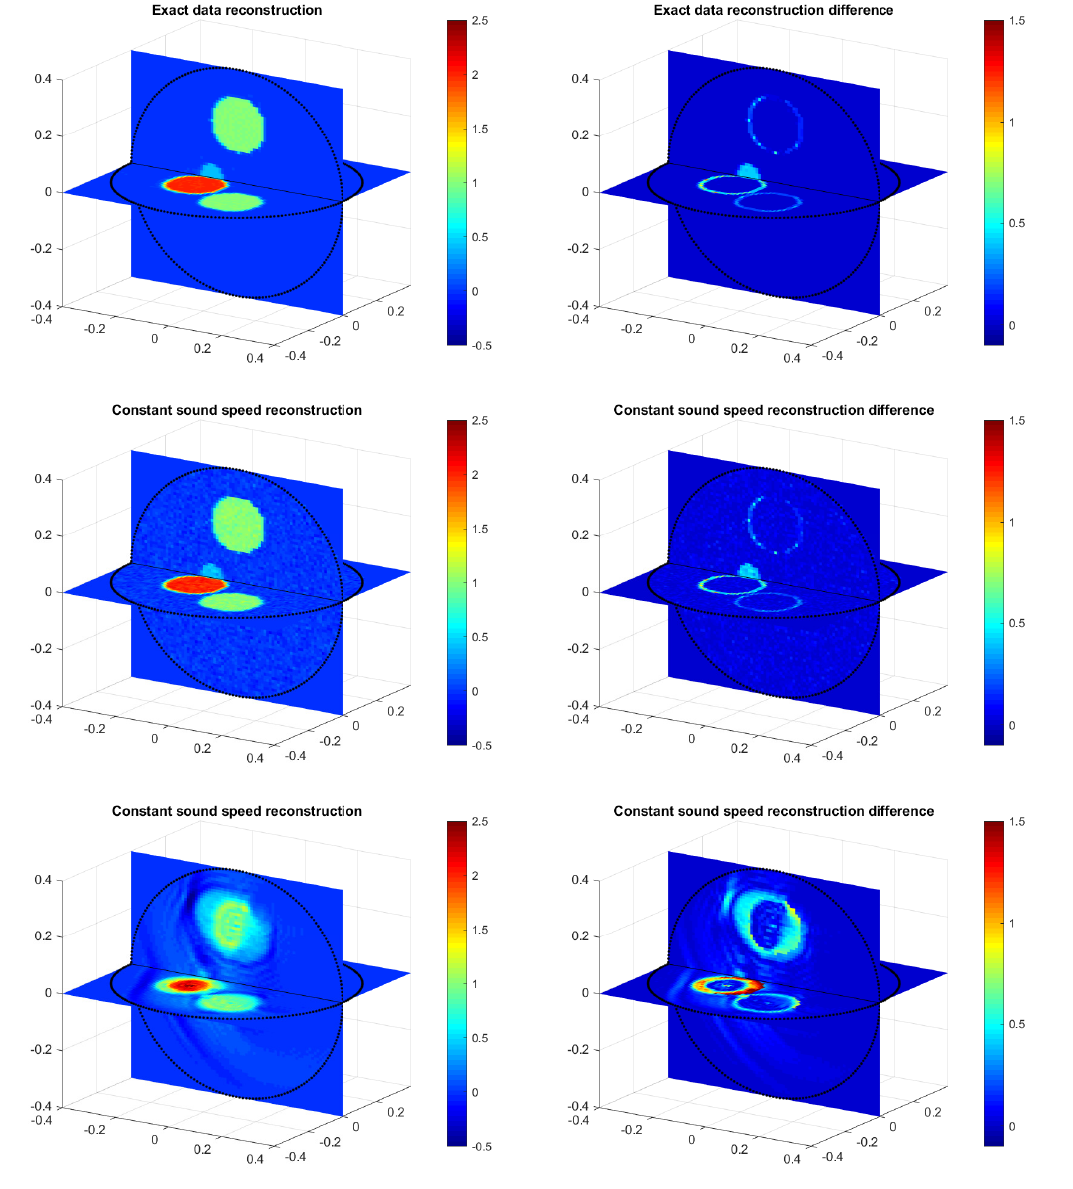
Figure 5. R ECONSTRUCTIONS f rec USING FIVE ITERATIONS OF THE STEEPEST DESCENT ALGORITHM ( LEFT ) AND THE DIFFERENCES | f rec − f (cid:63) | TO THE TRUE PHANTOM ( RIGHT ). ( Top ): Using simulated data g (cid:63) and correct sound speed c (cid:63) . ( Middle ): Using noisy data g and correct sound speed c (cid:63) . ( Bottom ): Using simulated data g (cid:63) data and wrong sound speed c 0